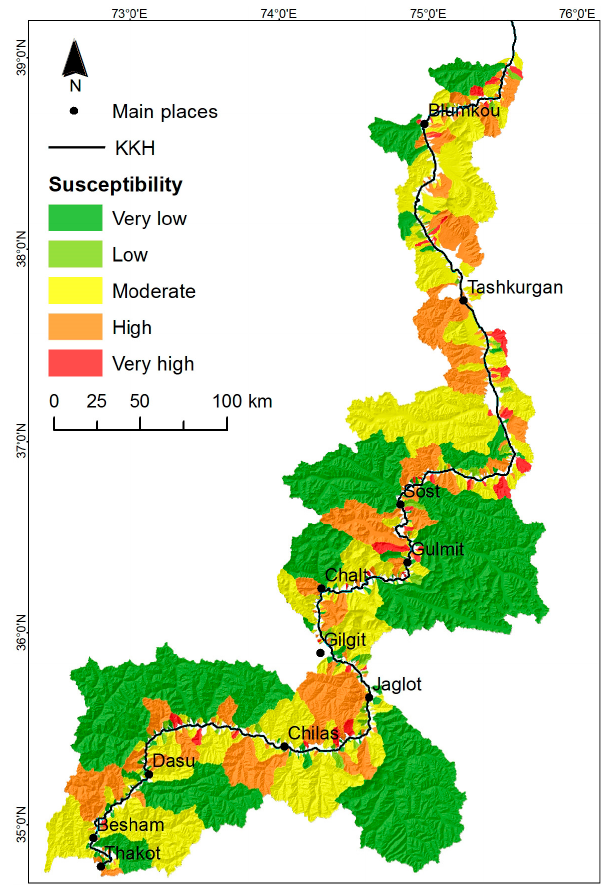
Figure 11. Susceptibility mapping results of the KKH area.